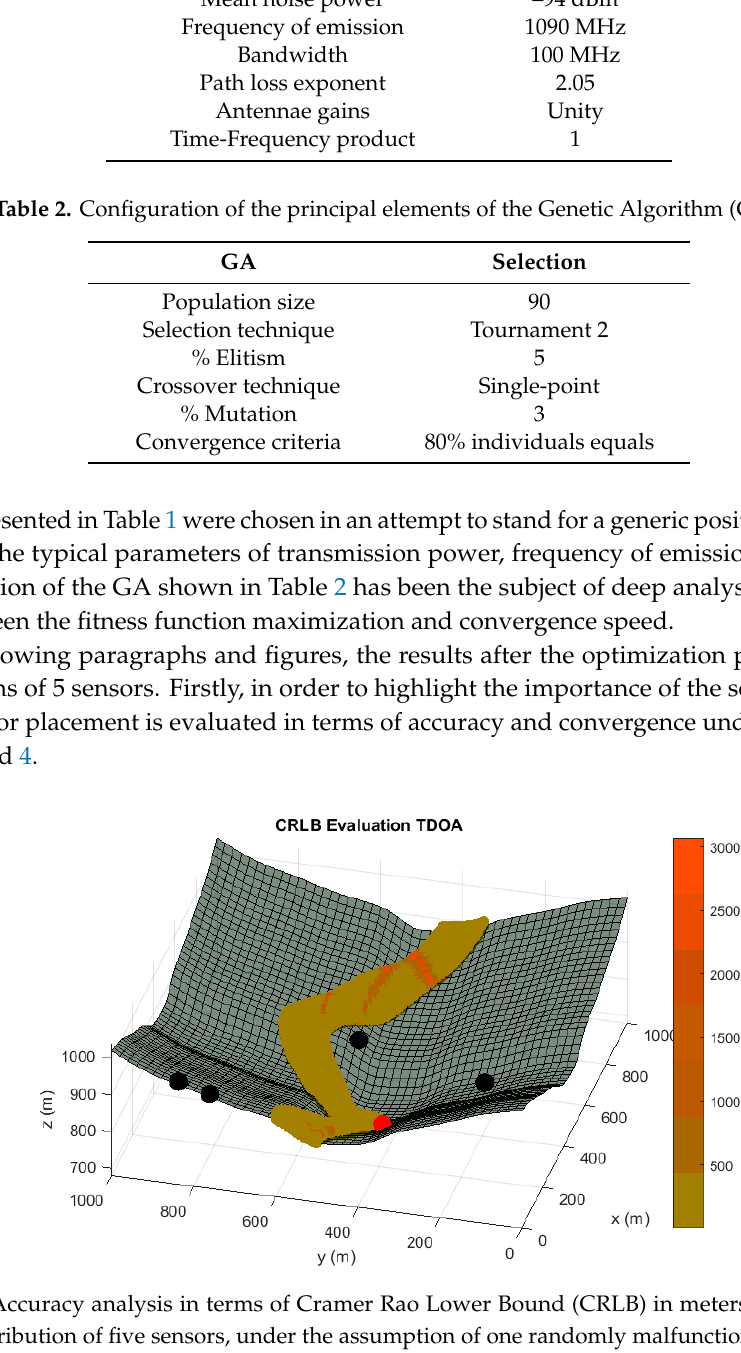
Figure 4. Convergence radius analysis in meters for a random sensor distribution of 5 sensors, under the assumption of one randomly malfunction sensor. The convergence radius represents the maximum radius of the sphere of convergence in which every inside point used as initial iterating point of the positioning algorithm guarantees the unequivocal position determination by using the four available sensors. It represents the same operating condition than Figure 2. Red tones in the color bar indicate bad convergence radius values, while green tones imply acceptable convergence magnitudes. As it is shown, the performance of this sensor distribution is not acceptable for any positioning service. The results for the optimized sensor placement with failure consideration, 5 sensors nominal operating conditions and convergence maximization (Case I) are provided in Figures 5 and 6 when one of the sensors is not available.